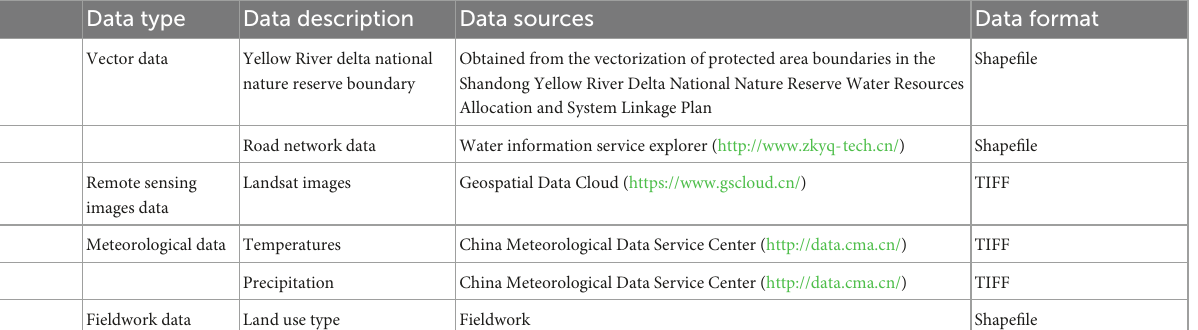
TABLE 1 Types and sources of data required in this